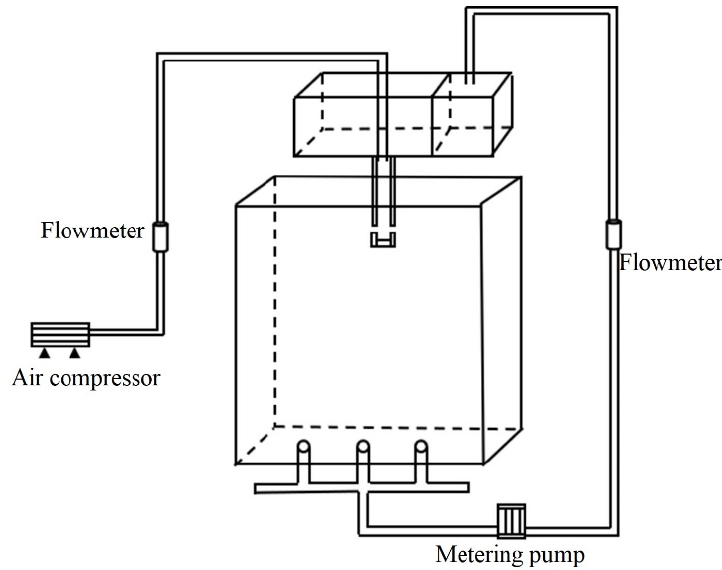
Figure 2. Water model experimental apparatus.